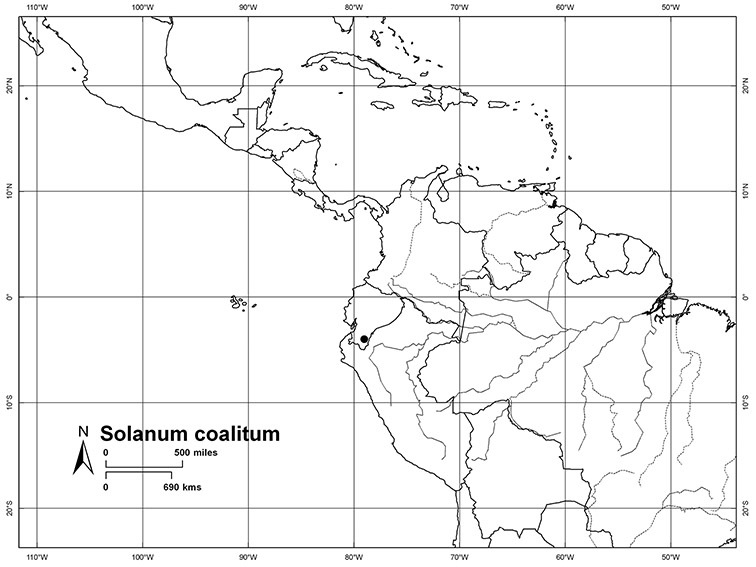
Distribution of Solanum coalitum S.Knapp.